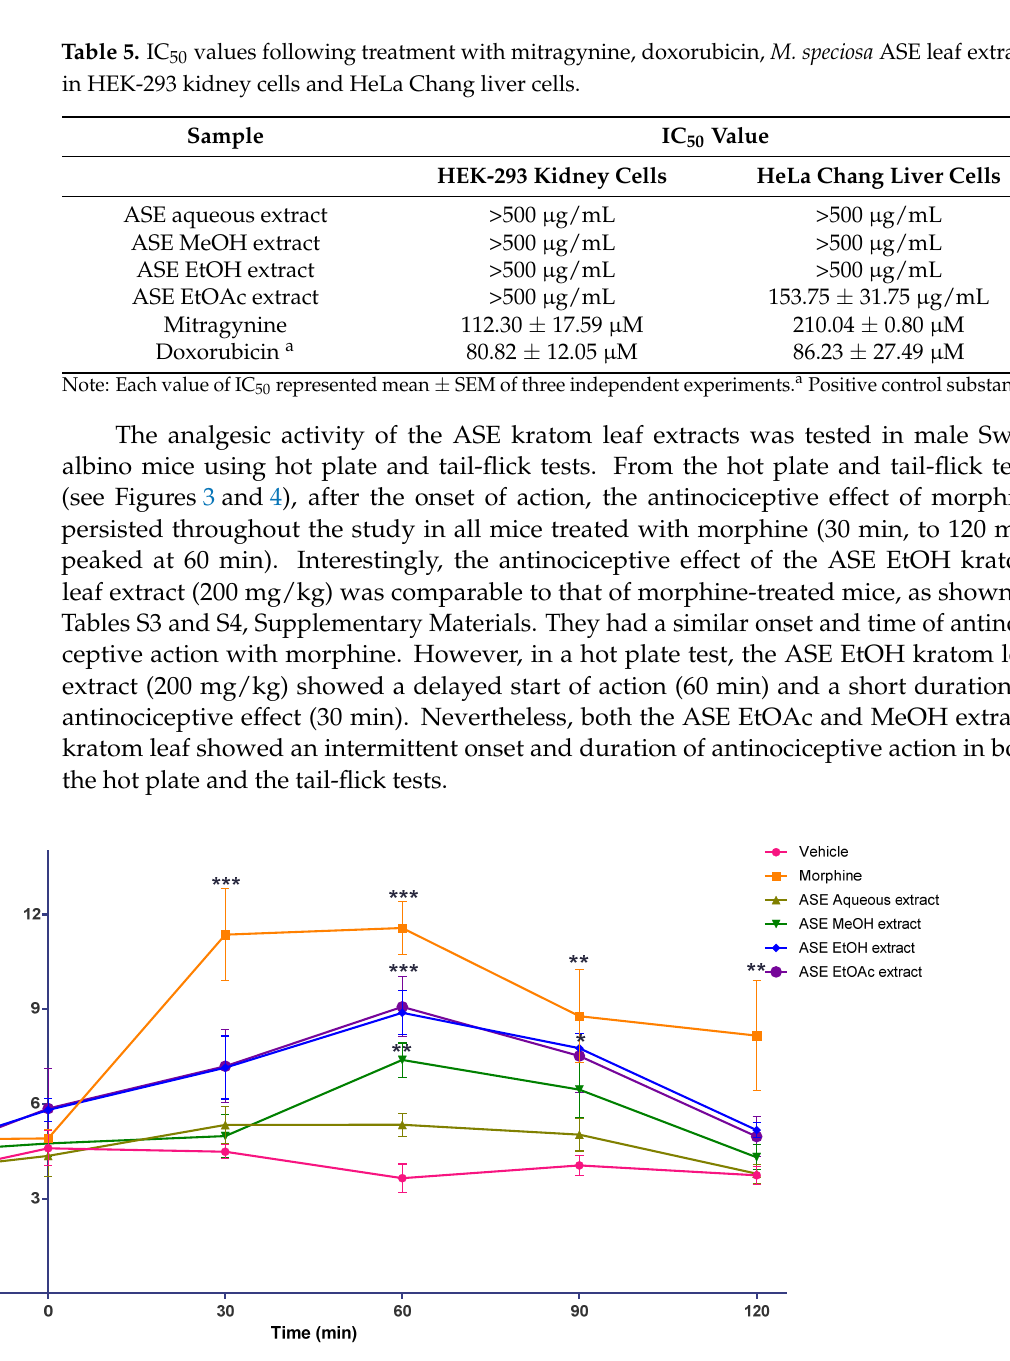
Figure 3. Effects of vehicle, morphine, and M. speciosa ASE leaf extracts on Swiss albino mice nociceptive response in a hot plate test. Extracts were administrated orally (morphine injection, s.c.), and nociceptive response was measured at 30 min interval over 120 min in mice. Data shown as mean ± SEM ( n = 6). * p < 0.05, ** p < 0.01, *** p < 0.001 compared with vehicle group (one-way ANOVA, followed by Dunnett’s test).